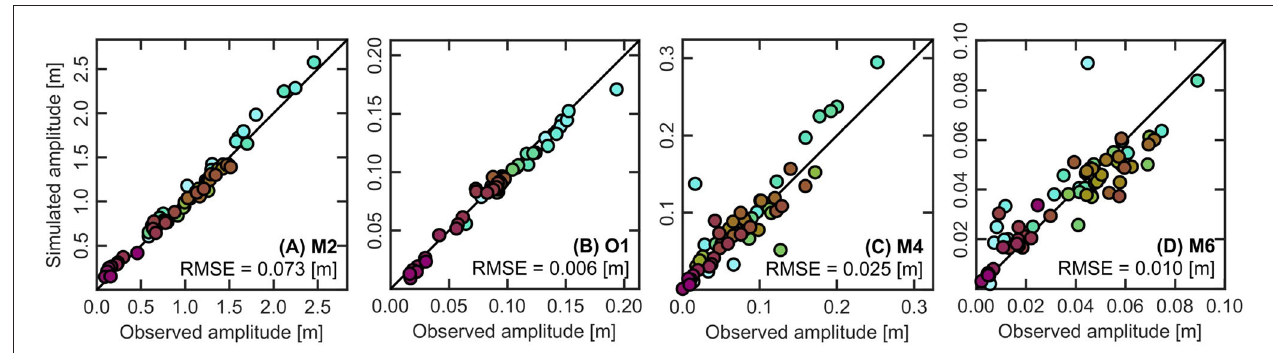
FIGURE 4 | Agreement of tidal constituents calculated by harmonic analysis of observed and simulated water levels, according to the 3-month period from September 1 to December 1, 2012. Comparison of observed and simulated amplitudes for the tidal constituents (A) M2, (B) O1, (C) M4, and (D) M6. The color codes and locations of tidal gauges are shown in Figure 1